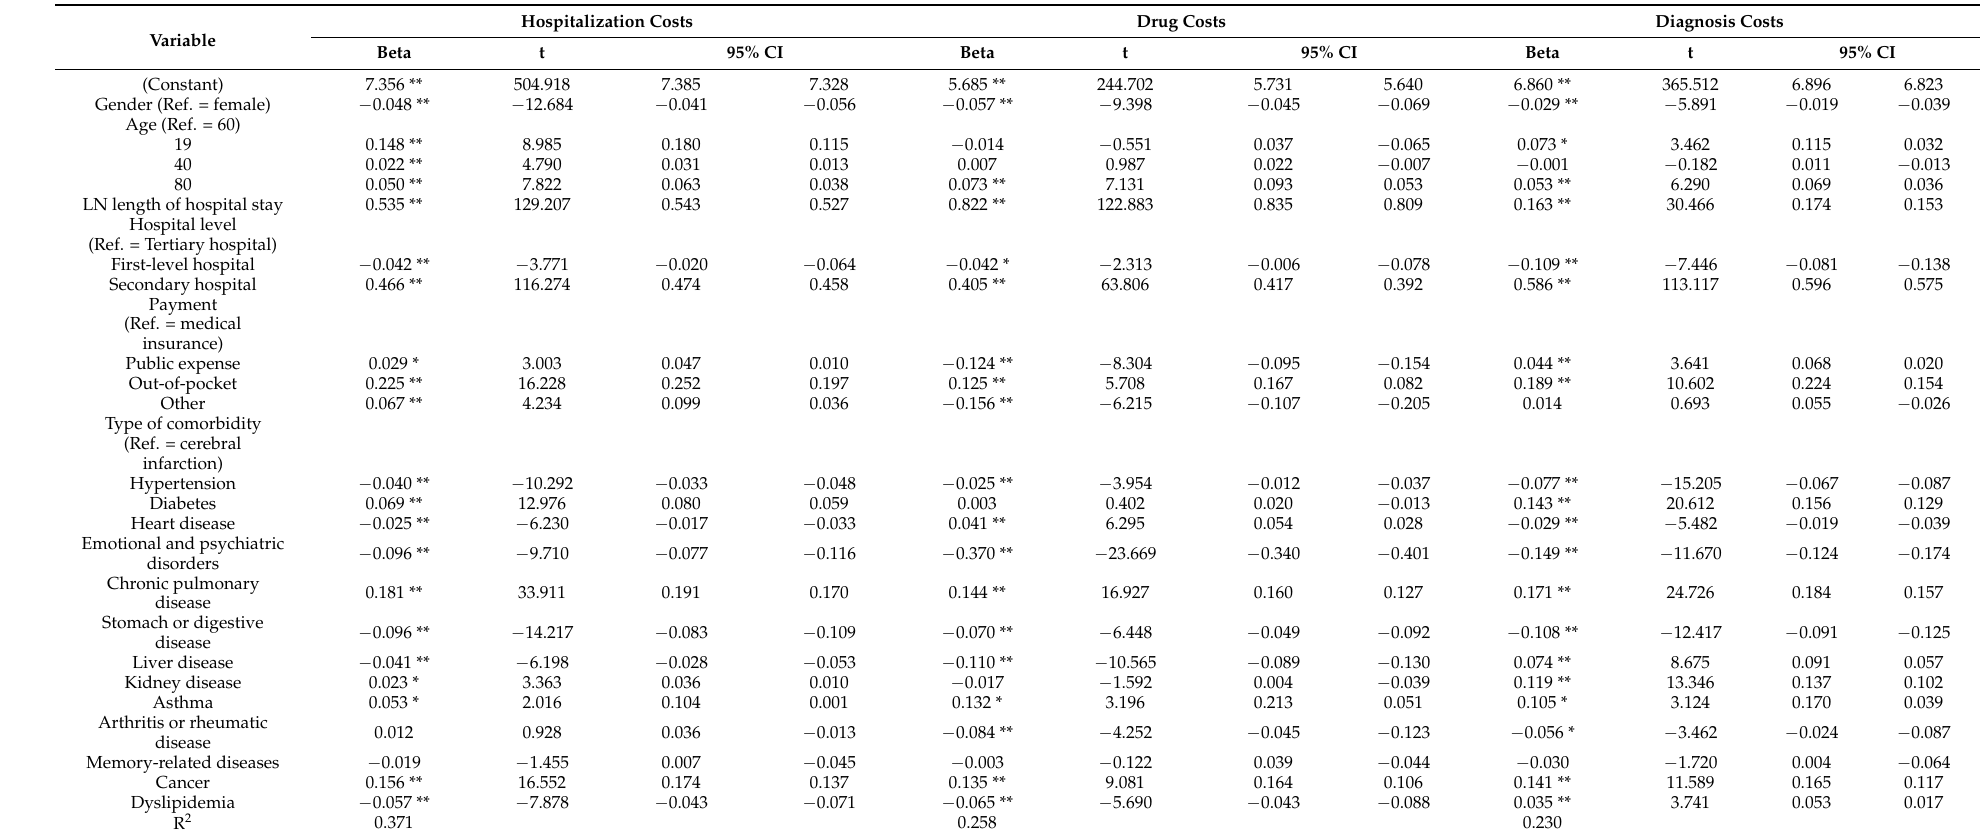
Table 4. Multiple linear regression analysis of the impacts of comorbidities on hospitalization